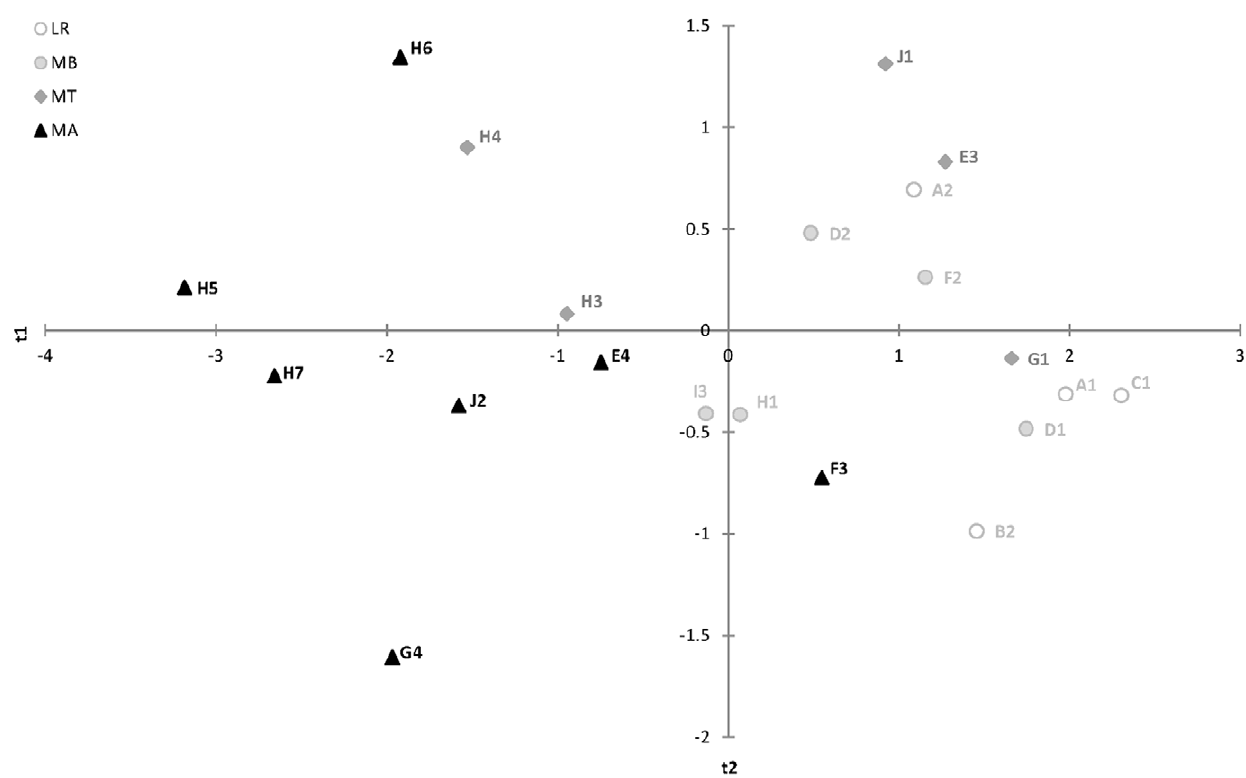
Figure 5. Morphological relationship between the a -Gpdh 100 allele and altitude in female Agabusbipustulatus . Agabus bipustulatus female score plot from the PLS analysis of the linear relationship between the first significant (R1) component between morphology ( partial warp ) N and the mean number of copies of the a -Gpdh 100 allele per populations, altitude and beetles size ( CS ). The correlation between the Y- and X-matrix ), at the tree line ( m ) and above ( & ). Population numbers are was 0.70. Populations from lowland region ( # ); mountain region below tree line ( given according to table 1.